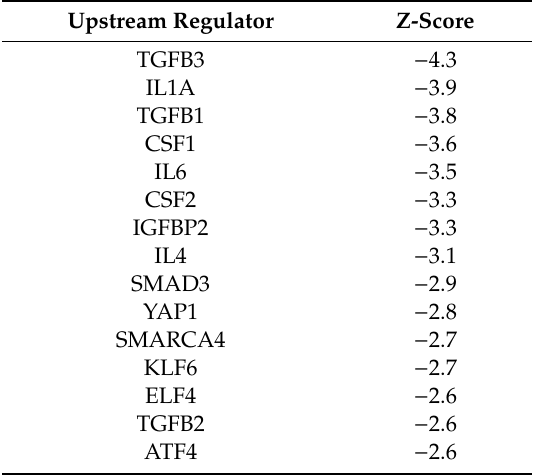
Table 5. Top 15 inhibited upstream regulators detected in the EBV-high sample by the Ingenuity pathway analysis (ranked by